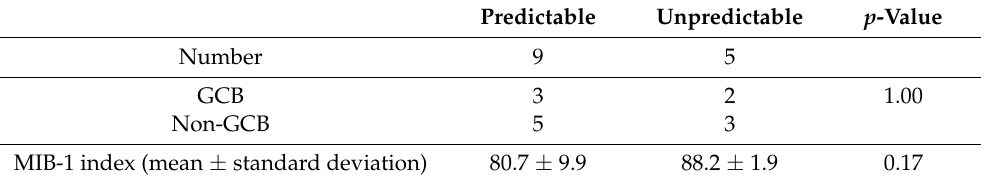
Table 3. The subtype and MIB-1 index of predictable and unpredictable PCNSLs.